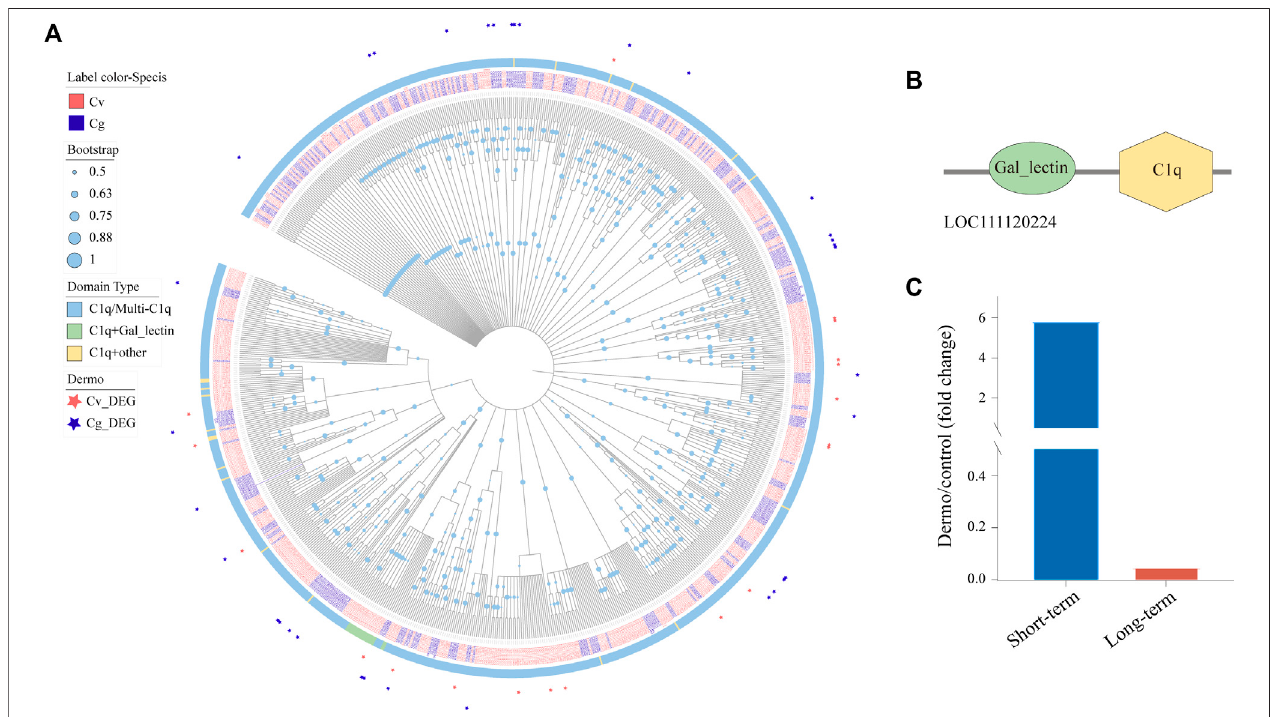
FIGURE 7 | Expansion of C1qDCs and divergent expression patterns under P. marinus challenge between C. virginica and C. gigas . (A) , Phylogenetic tree constructed with the maximum likelihood method showing lineage-speci fi c expansion of C1qDCs in C. virginica (red font) and C. gigas (gray font). Different color backgrounds represent different types of C1qDC domain composition, and the red and gray asterisks represent differentially expressed C1qDCs under P. marinus challenge in C. virginica and C. gigas , respectively. (B) , Domain composition of the “ galactose-binding lectin ” containing C1qDC gene. (C) , A C1qDC gene (LOC111120224) with “ galactose-binding lectin ” domain was signi fi cantly upregulated in C. virginica after P. marinus challenge.